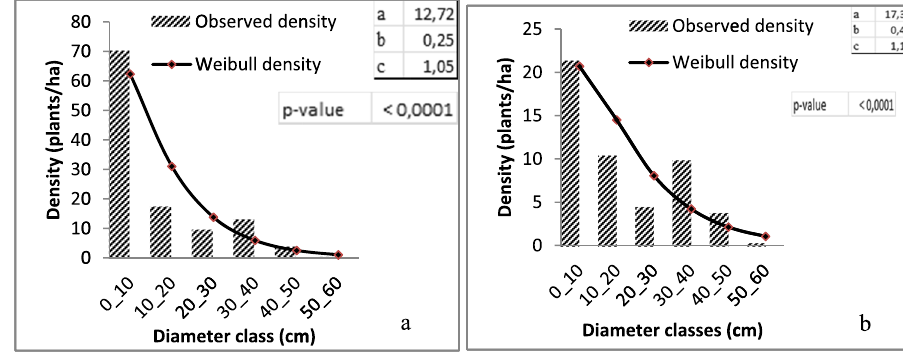
Fig. 2 Structure in diameter class of the woody population of the Dan Saga cluster (a case of plots with practice and b case of control